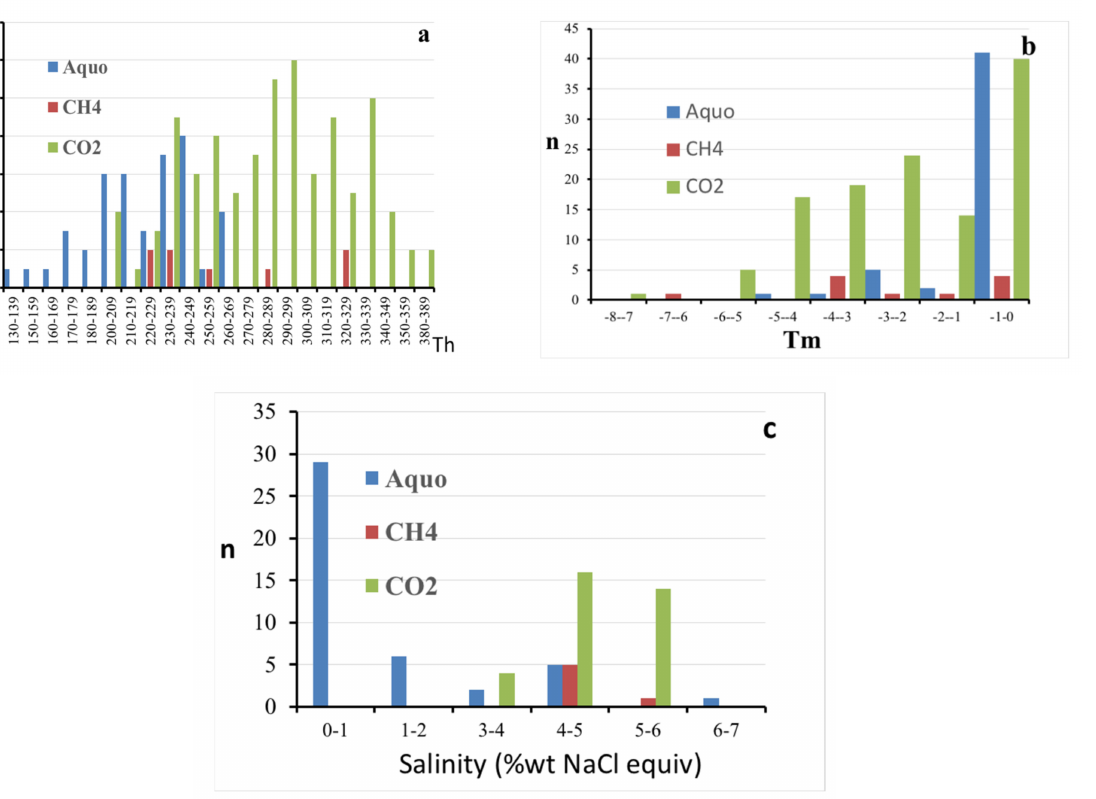
Figure 11. Histograms of T h ( a ), T m ( b ), and salinity of fluid inclusions ( c ) in scheelite from Borralha. The T mi and salinity histograms show that the hotter fluids were saltier (with about 5 wt.% NaCl equiv.) than the aqueous colder fluids which mixed at the end of the process. In addition, averages of the bulk compositions and densities of the FIs studied were calcu- lated (see Table 4). No distinction between the primary and pseudosecondary inclusions could be established using the microthermometry of the fluid inclusion assemblages, but rather on the composition of the fluids. Raman spectrometry analyses were performed on representative aqueous-carbonic type (CO 2 or CH 4 dominant) FIs, where differences in the CO 2 /CH 4 ratio were identified (Figure 12 and Table S1 in the Supplementary Materials).